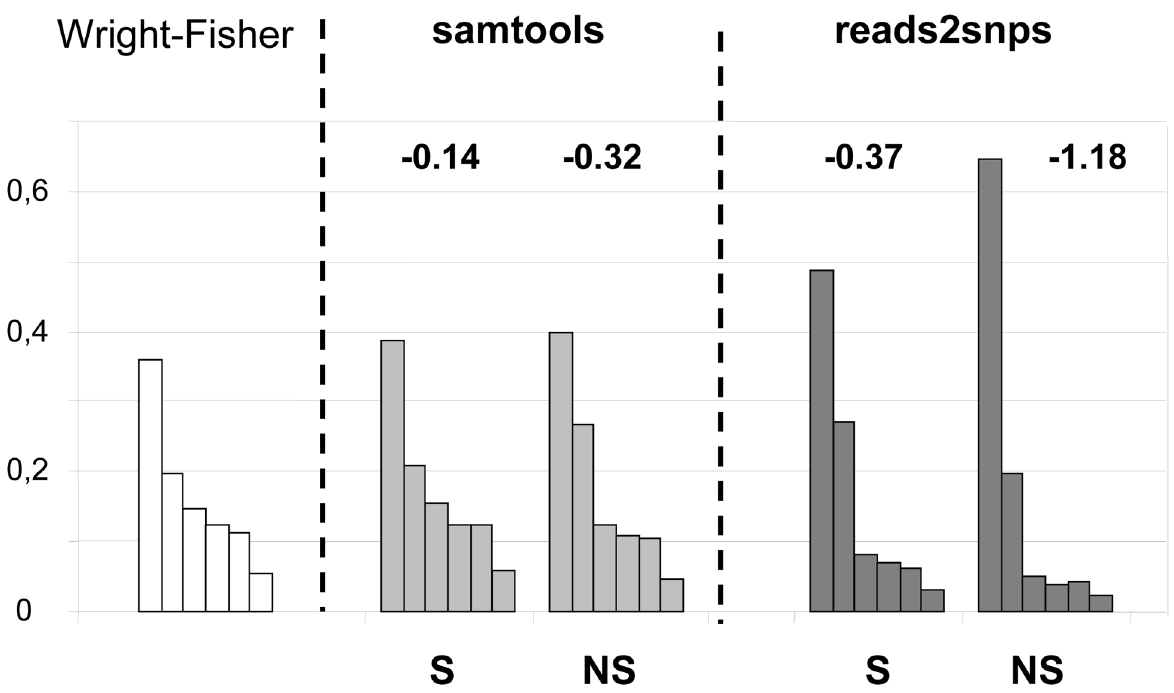
Figure 2. Synonymous and non-synonymous site-frequency spectra in the hare Lepus granatensis . Each histogram displays the distribution of minor allele frequency across SNPs (folded site-frequency spectrum) for a sampling size of 12 chromosomes. The left-most histogram is the expected spectrum for neutral sites in a Wright-Fisher population. The other four histograms were drawn from the data, calling SNPs with either Samtools or reads2snps, and separating non-synonymous (NS) from synonymous (S) positions. The number above each histogram is Tajima’s D. This index is equal to zero in the Wright-Fisher case.